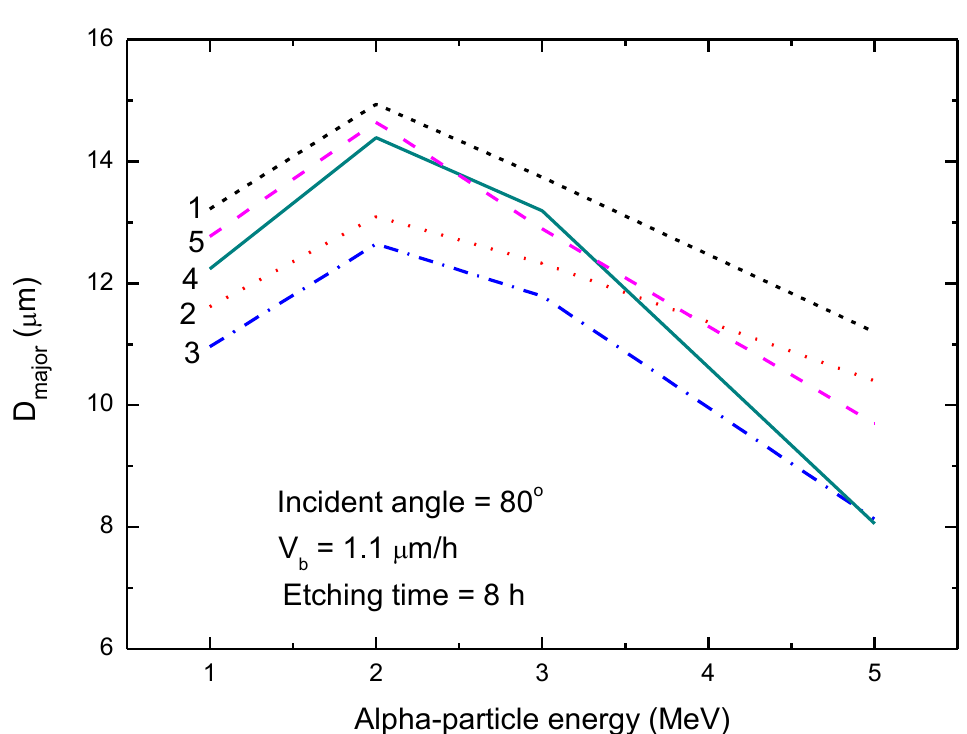
Figure 1. Relationship between the major-axis length ( D major ) of the track opening in the CR-39 detector and the alpha-particle energy for the incident angle of 80 ◦ for the five V functions implemented in the revised TRACK_TEST program. The experimental conditions are given in Figure. 1: V function No. 1 [13], 2: V function No. 2 [14], 3: V function No. 3 [15], 4: V function No. 4 [19] and 5: V function No. 5 [20]. Functions 4 and 5 were newly added in the revised TRACK_TEST program. Table 1. Parameters of the V function V ( R (cid:48) ) for the Makrofol detector described in Equation (3). 1